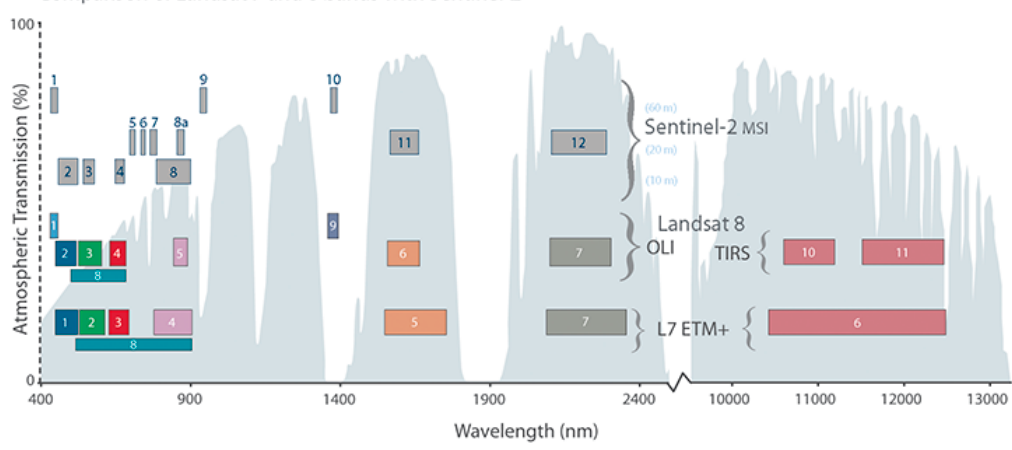
Figure 1. Comparison of spectral bands of Landsat 7 ETM+, Landsat-8, and Sentinel-2 (source: https://eros.usgs.gov/sentinel-2).